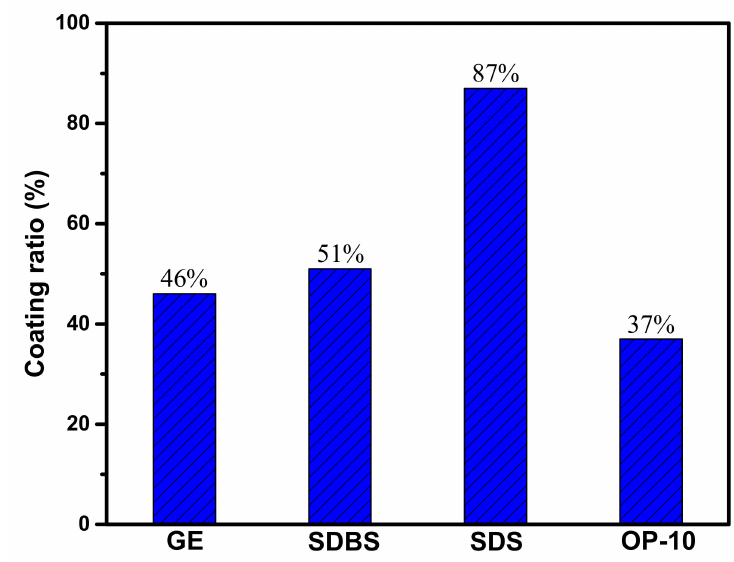
Figure 3. Coating ratio of microcapsules with different emulsifiers.